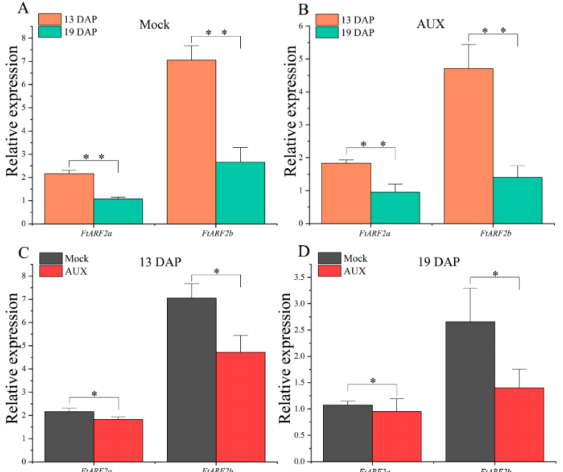
Figure 5. Expression analysis of the two FtARF2 genes in the STB fruits at 13 and 19 DAP under mock and IAA treatments. ( A ) Expression analysis of the two FtARF2 genes in the STB fruits at 13 and 19 DAP under mock treatments. ( B ) Expression analysis of the two FtARF2 genes in the STB fruits at 13 and 19 DAP under IAA treatments. ( C ) Expression analysis of the two FtARF2 genes in the STB fruits at 13 DAP under mock and IAA treatments. ( D ) Expression analysis of the two FtARF2 genes in the STB fruits at 19 DAP under mock and IAA treatments. * and ** indicate significant differences at 0.05 and 0.01 levels,